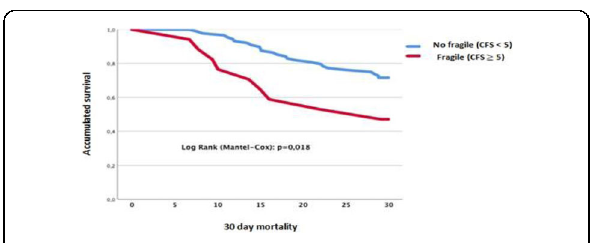
Fig. 3 (abstract 001051). See text for